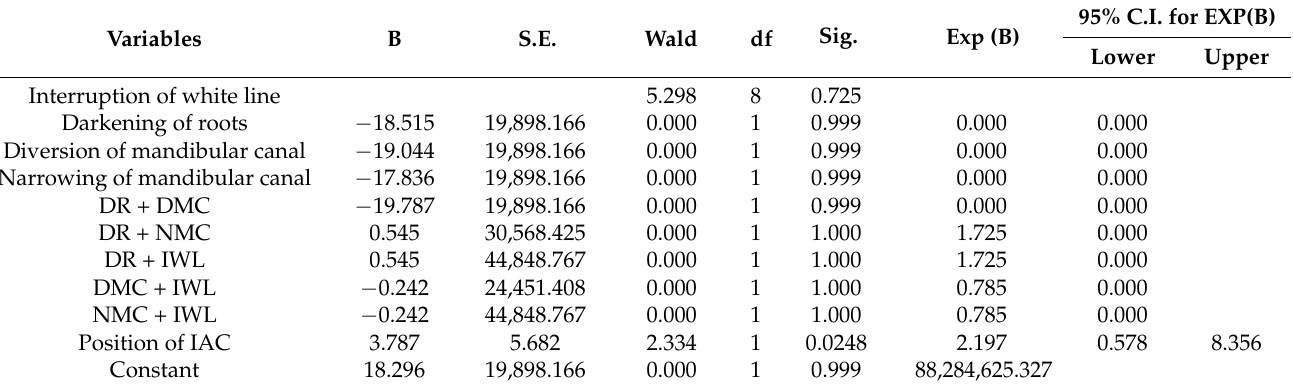
Table 3. Binomial logistic regression to predict the factors associated with